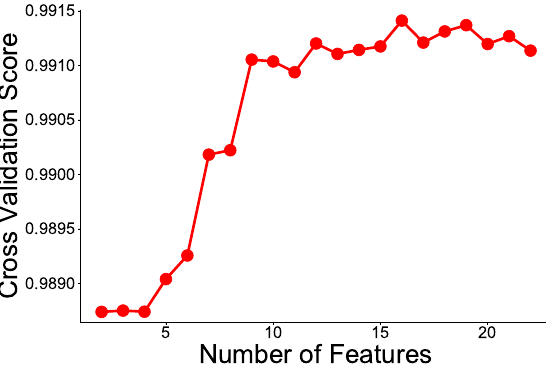
Figure 8. RFE cross-validation score with respect to the number of features.